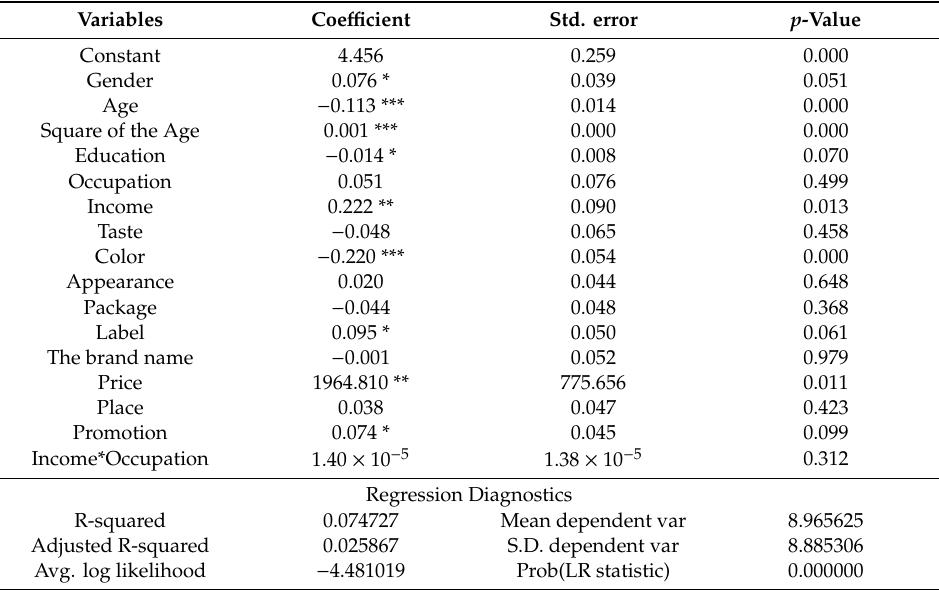
Table 6. Results of the Poisson regression of consumers’ frequency of purchases of locally-produced rice (n =